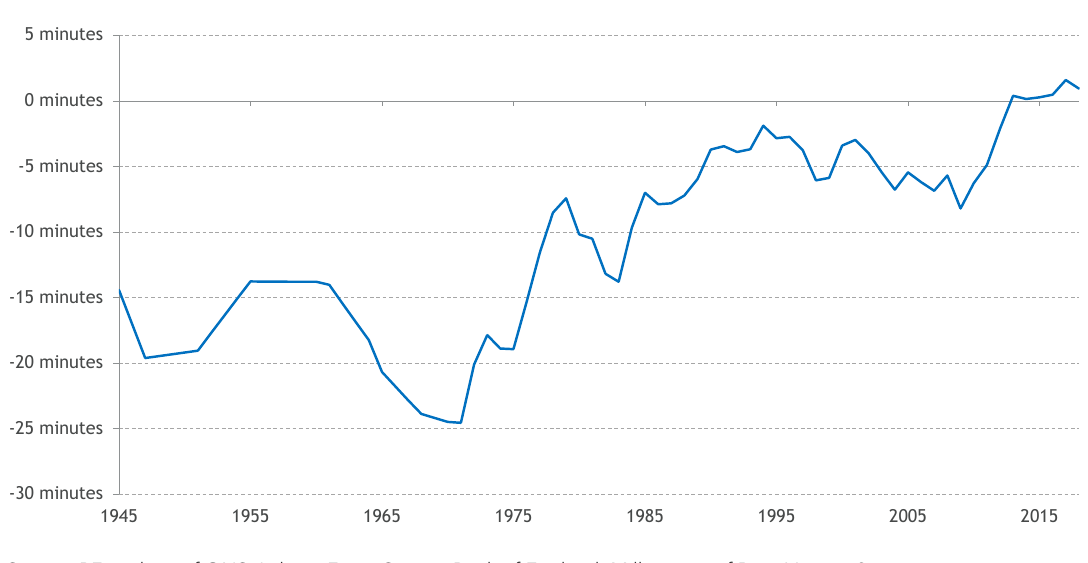
Figure 3: The financial crisis bought an end to half a century of falling hours